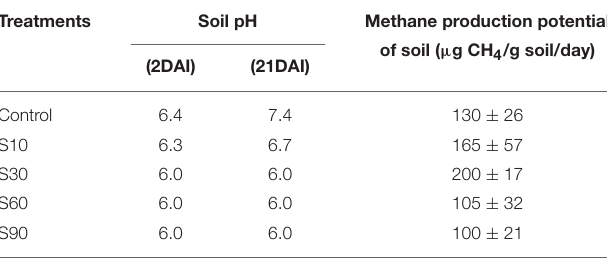
TABLE 2 | Results of laboratory incubation